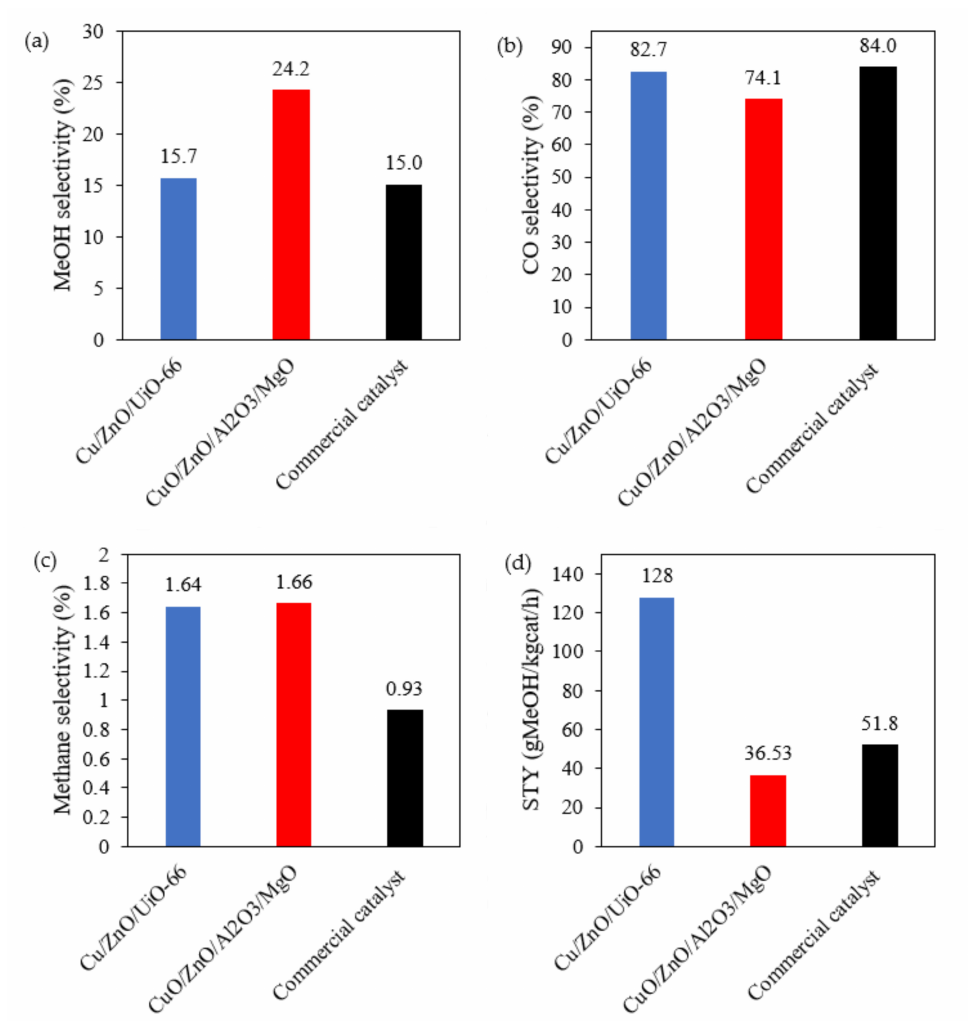
Figure 7. Catalysts’ ( a ) methanol selectivity; ( b ) CO selectivity; ( c ) methane selectivity and ( d ) space– time